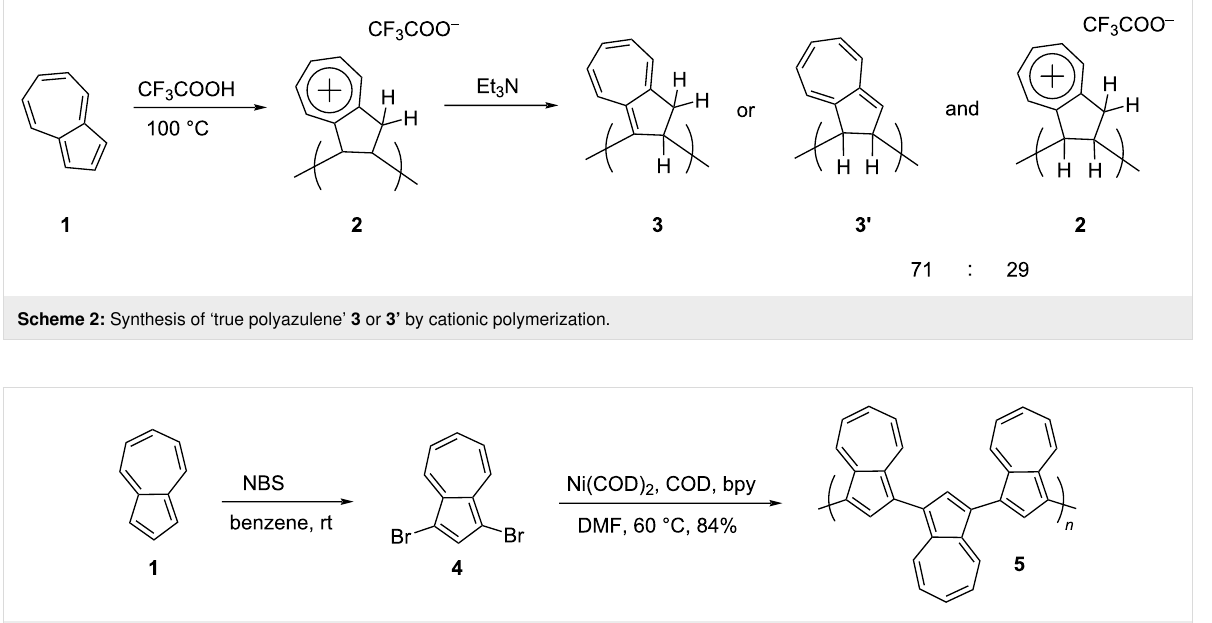
Scheme 3: Synthesis of 1,3-polyazulene 5 by Yamamoto